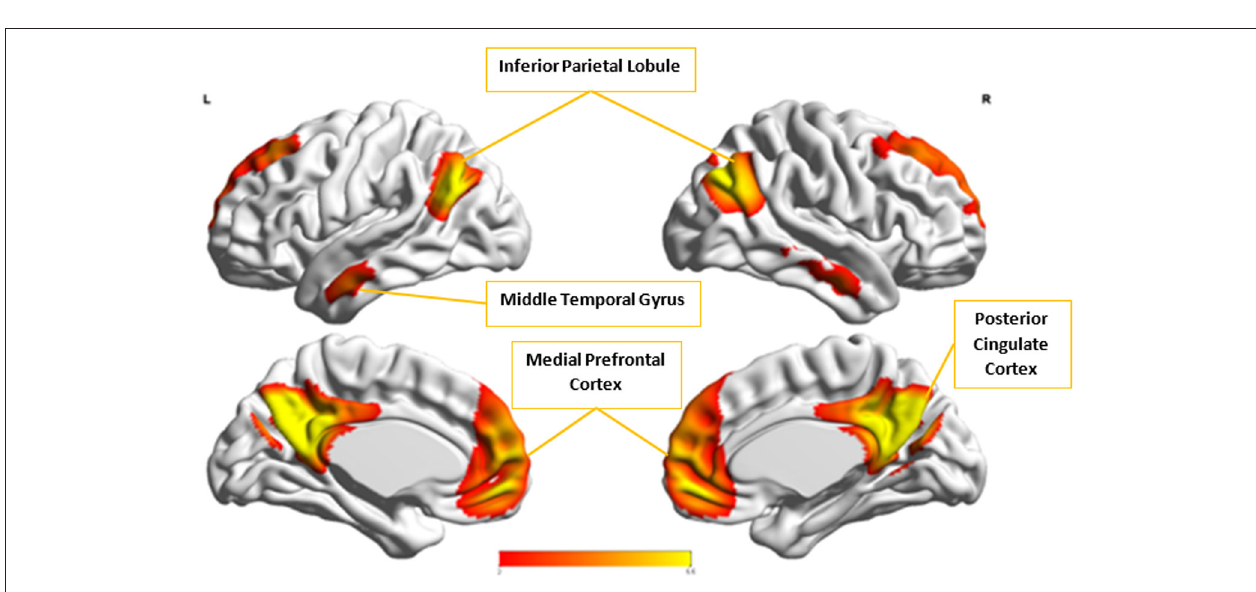
FIGURE 9 | The group-level component, C x , from Control group that produced the highest cluster purity value of 0.971 when combined with another group-level component, A x , from the Autism group. These regions represent the default mode network